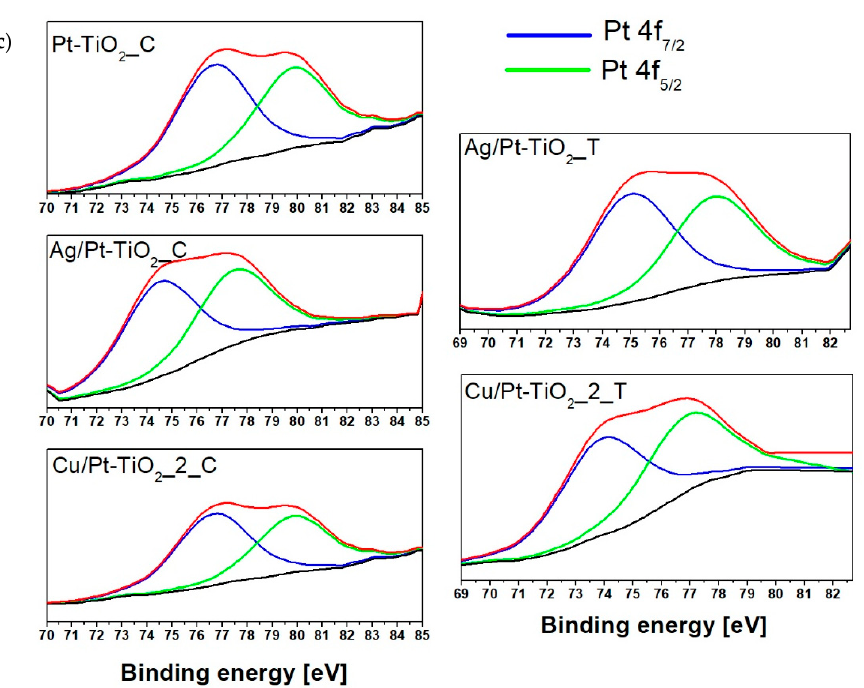
Figure 2. Deconvolution of X-ray photoelectron spectroscopy (XPS) spectra for ( a ) Ag 3d, ( b ) Cu 2p and ( c ) Pt 4f.